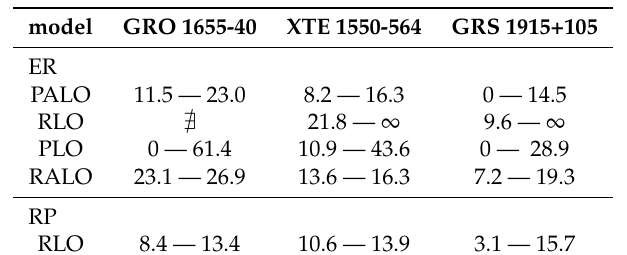
Table 3. Magnitude of magnetic filed for three microquasars, obtained by the fitting of the HF QPO frequencies with the frequencies of the oscillations of an electron. We use combined values for the ER model related to the 3:2 and 2:3 resonances (Table 2); similarly for the RP model. All numbers in the table are in units of 10 − 5 Gauss for electrons (around 2 × 10 − 2 Gauss for protons). model